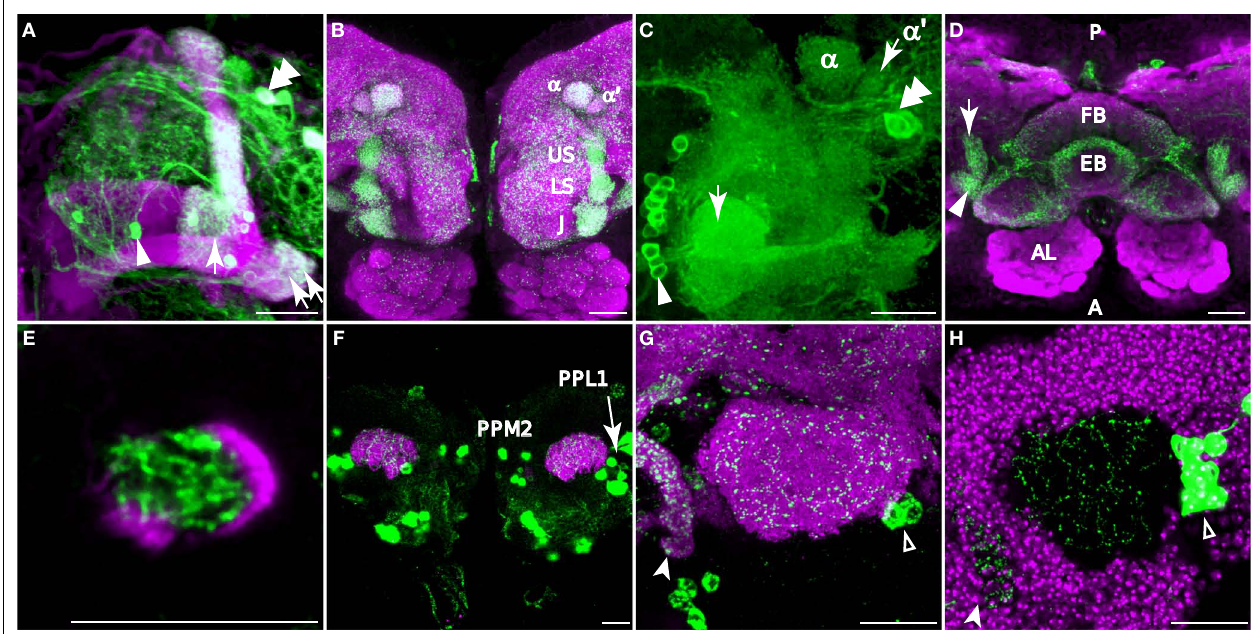
FIGURE 3 | Dopaminergic innervation of the mushroom bodies. Scale bar in all panels: 20 µm. (A–C) Innervation of the lobes as viewed from the anterior. (A) TH-GAL4 driven GFP expression in the vertical lobes, the junction (arrow), and the heel (double arrows). Note the sharp vertical boundary of green fl uorescence just medial to the junction in the horizontal lobes, giving the impression that dopaminergic innvervation excludes much of the horizontal lobes. Magenta, anti- FasII. Arrowhead, a PAM neuron. Double arrowhead, PAL neurons. Medial is to the left; lateral to the right. (B) TH-GAL4 driven UAS-syt.eGFP , showing dense synaptic puncta (green) within several zones of innervation of the vertical lobes, including the junction (J), the lower stalk (LS), the upper stalk (US), the tip of the α′ lobe ( α′ ) and the tip of the α lobe ( α ). Magenta, anti-nc82. (C) Robust anti-TH immunostaining of the medial tips of the horizontal lobes (arrow). Medial is to the left; lateral to the right. Arrowhead, PAM neurons. Double arrowhead, PAL neurons. (D) Dorsal view of dopaminergic innervation of the distal